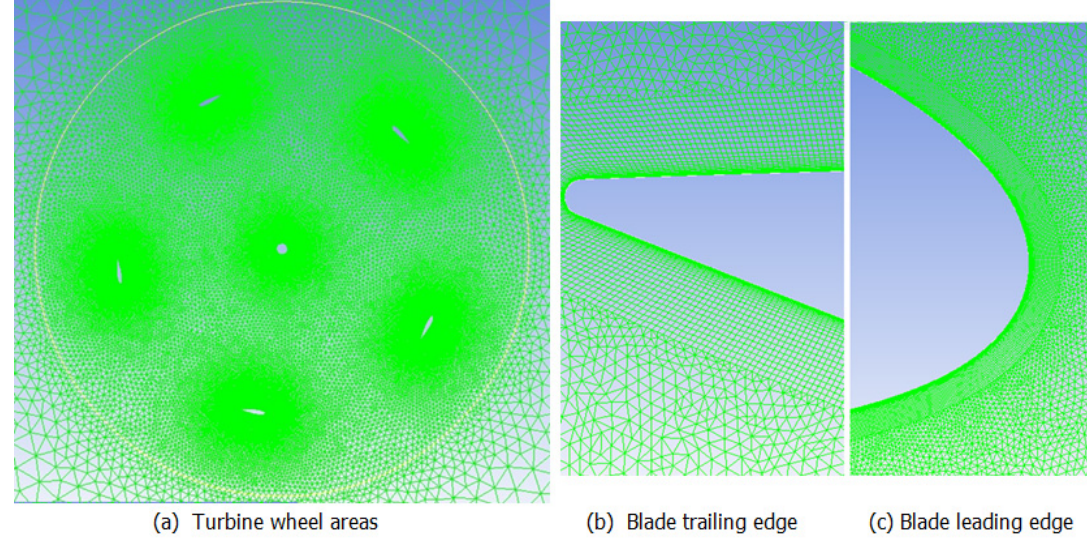
Figure 17. Selected CFD mesh: ( a ) turbine wheel area, ( b ) blade trailing edge, and ( c ) blade leading edge.